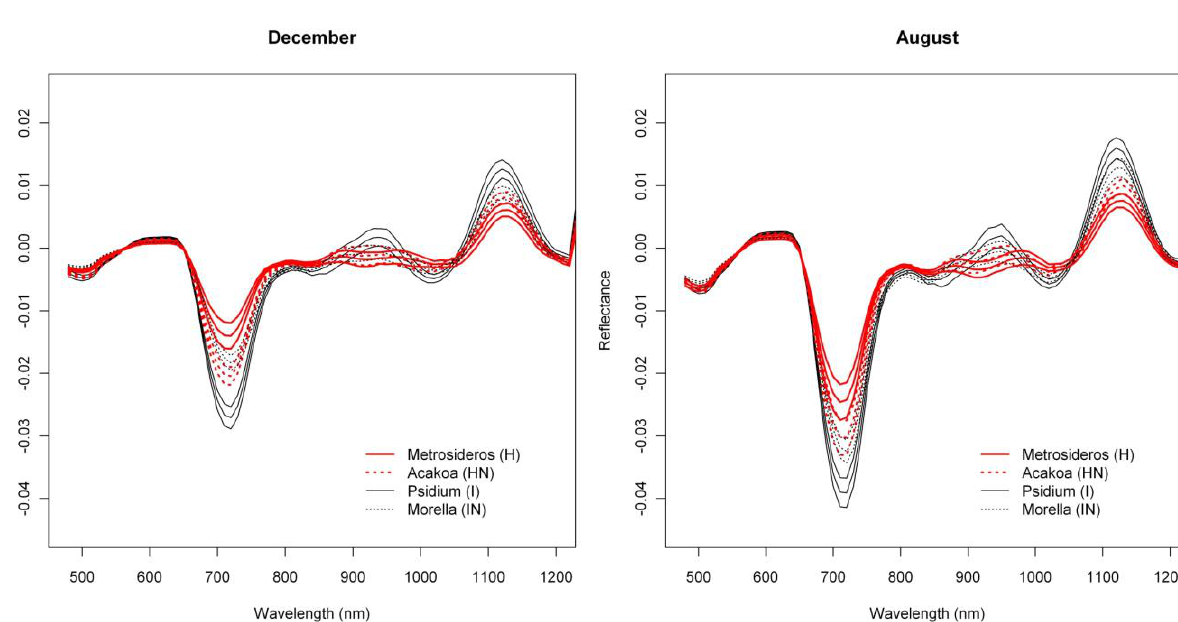
Figure 7. Mean and 95% confidence interval for December and August 1d-reflectance of native and invasive species. Approximately 400 spectra (or image pixels) were selected for each species (see Section